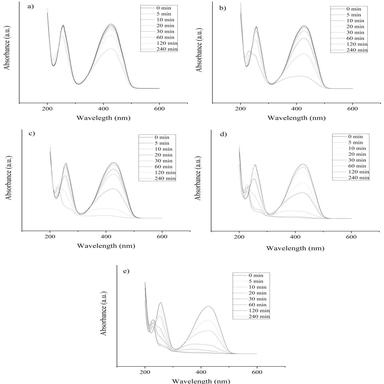
UV–Vis spectra for catalytic tests with tartrazine (C0 = 50 mg dm−3, V = 200 cm3 , mcat = 5 mg and 1.30 mmol Oxone® per 1 g of catalyst) performed at: a) 30 °C, b) 40 °C, c) 50 °C, d) 60 °C and e) 70 °C.